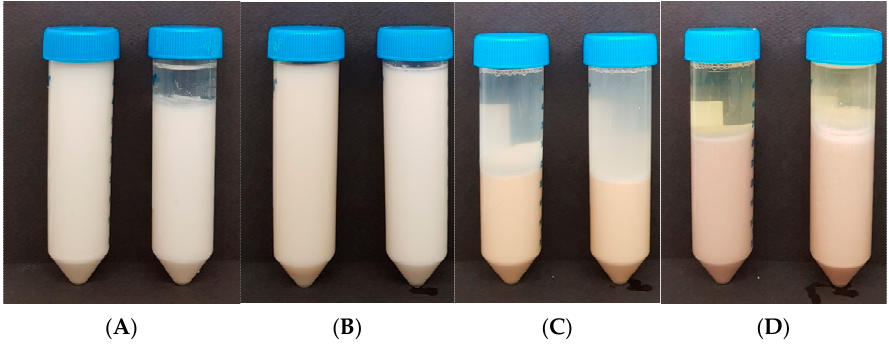
Figure 5. Syneresis of plant protein powder solutions (5%, w / w ) before and after fermentation. ( A ) isolated soy protein (ISP), ( B ) pea protein (PP), ( C ) rice protein (RP), and ( D ) almond protein (AP). (left: before fermentation, right: after